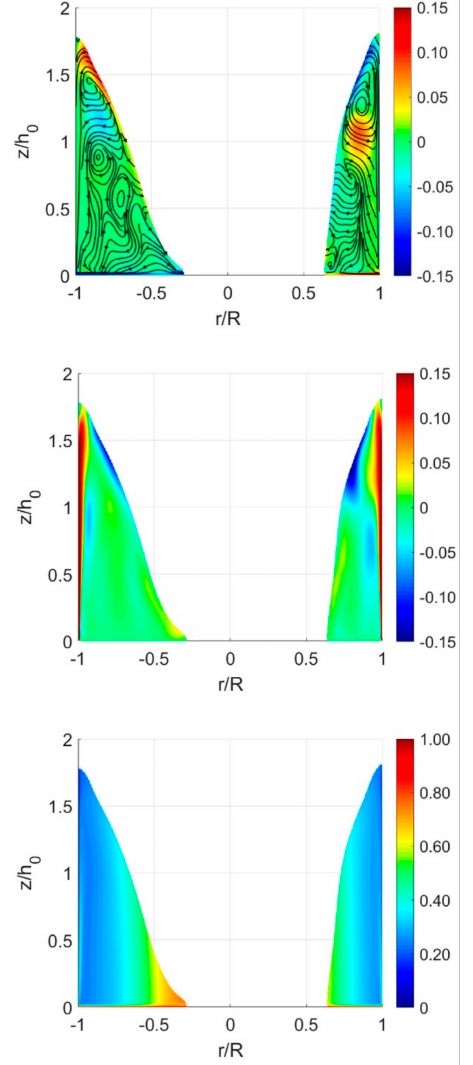
Figure 11. Front view contours of the radial, axial (both in m/s) and normalized tangential velocities for the vertical cross-section of the triangle, at the at the disk rotation frequency of 4.6 Hz. Each picture represents averaging of 1095 planes which are taken over the time span of 36.5 s (3 planes for every 0.1